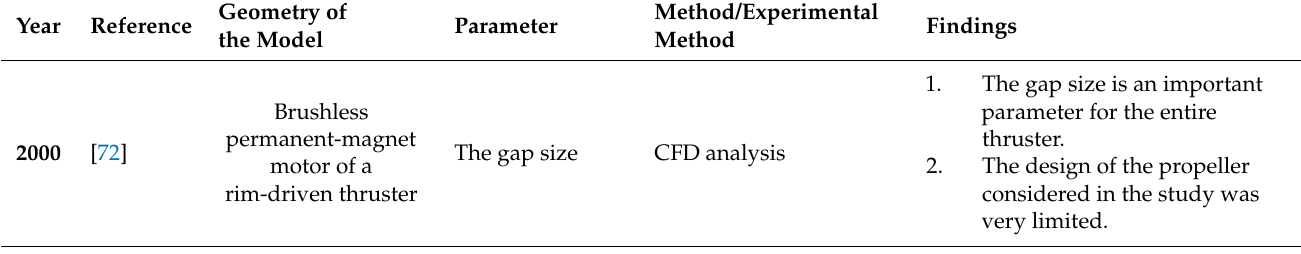
Table 5. Summary of the effect of the gap-flow model on the hydrodynamic performance of IMP